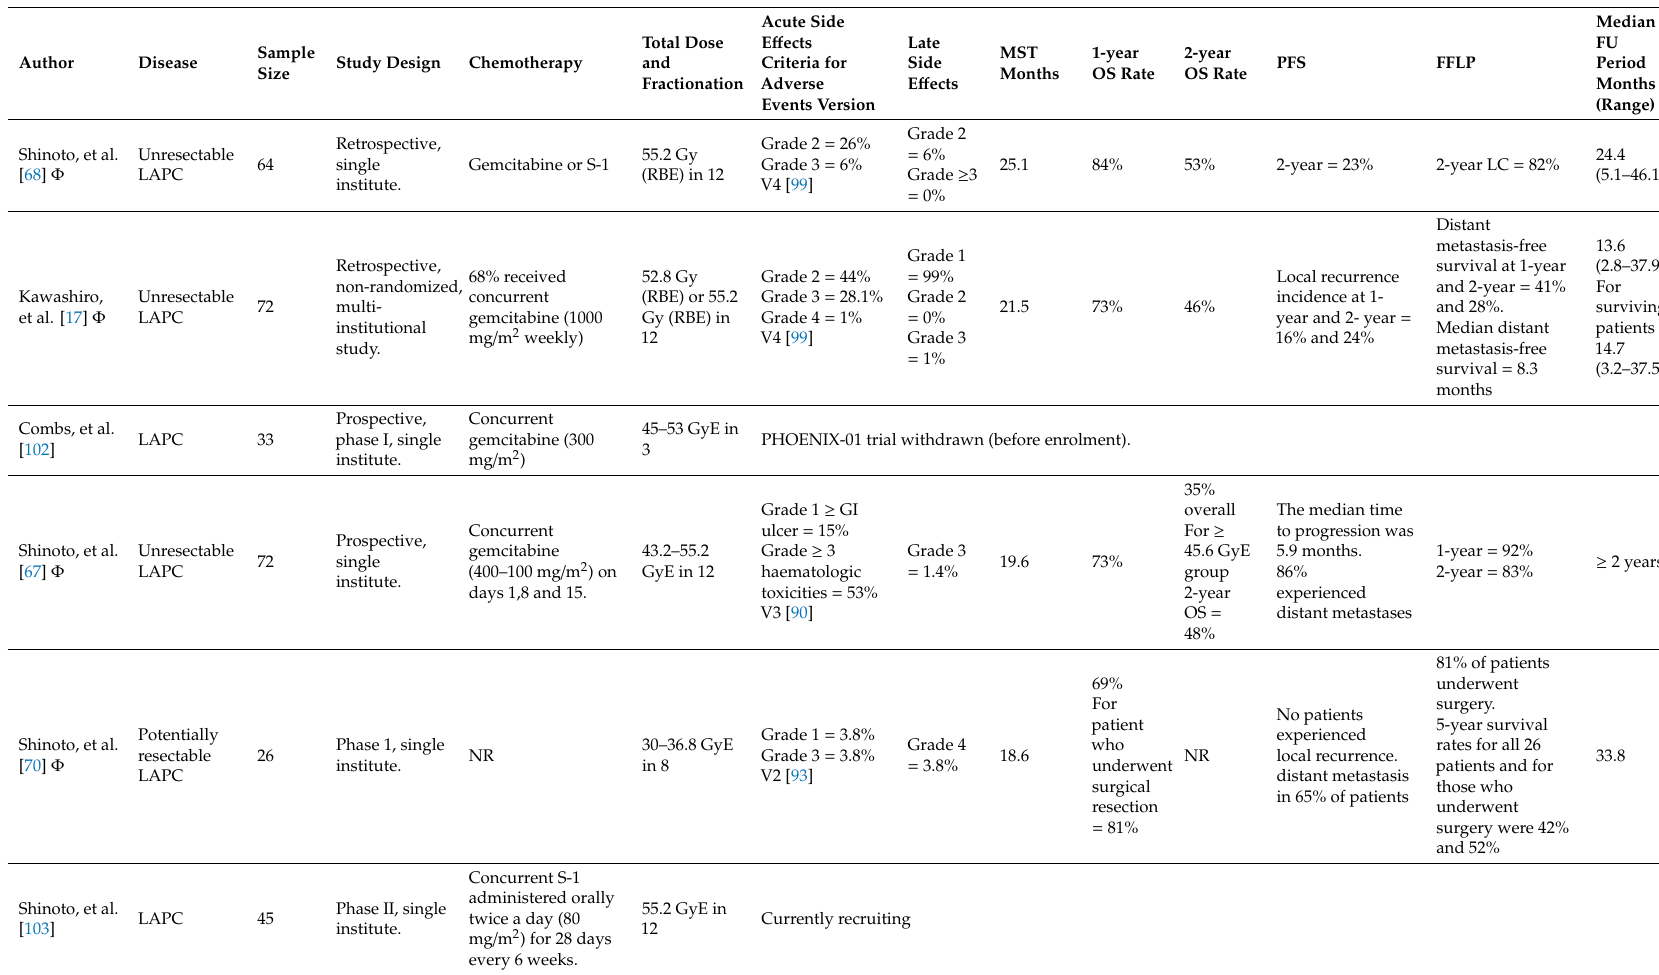
Table 4. Review of carbon ion therapy pancreatic cancer clinical studies